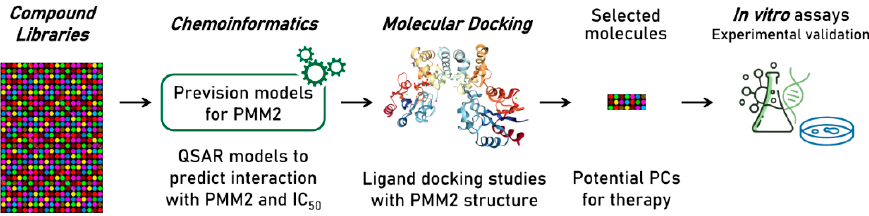
Figure 1. Simplified workflow for CADD approach to screen compounds for potential PCs for PMM2-CDG therapy.